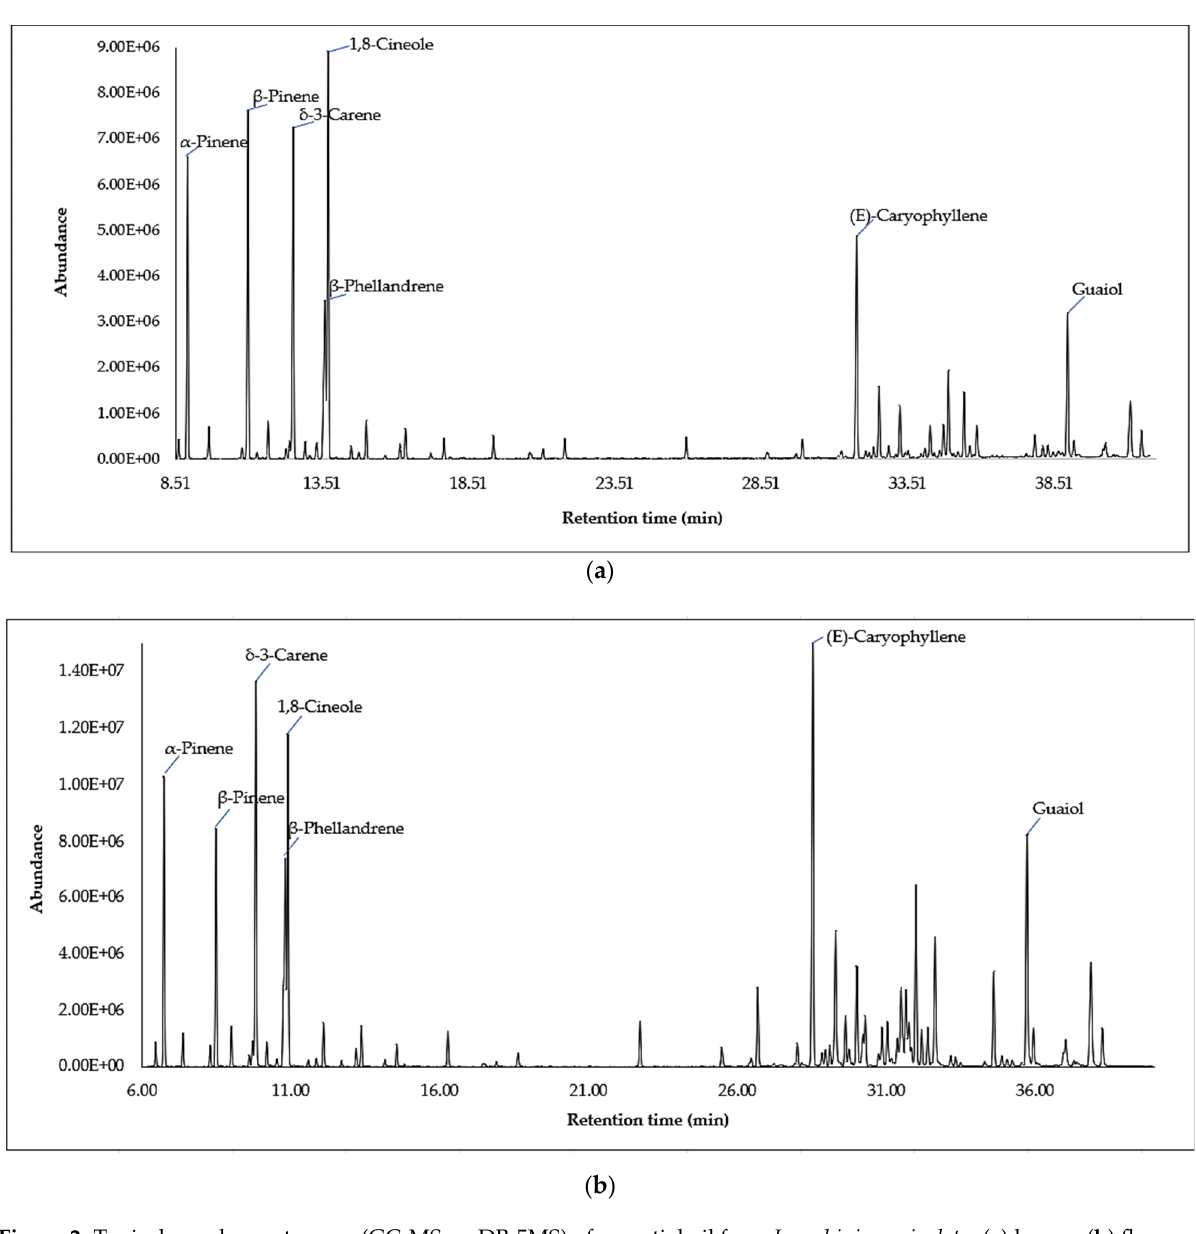
Figure 2. Typical gas chromatogram (GC-MS on DB-5MS) of essential oil from Lepechinia paniculata : ( a ) leaves; ( b ) flowers.